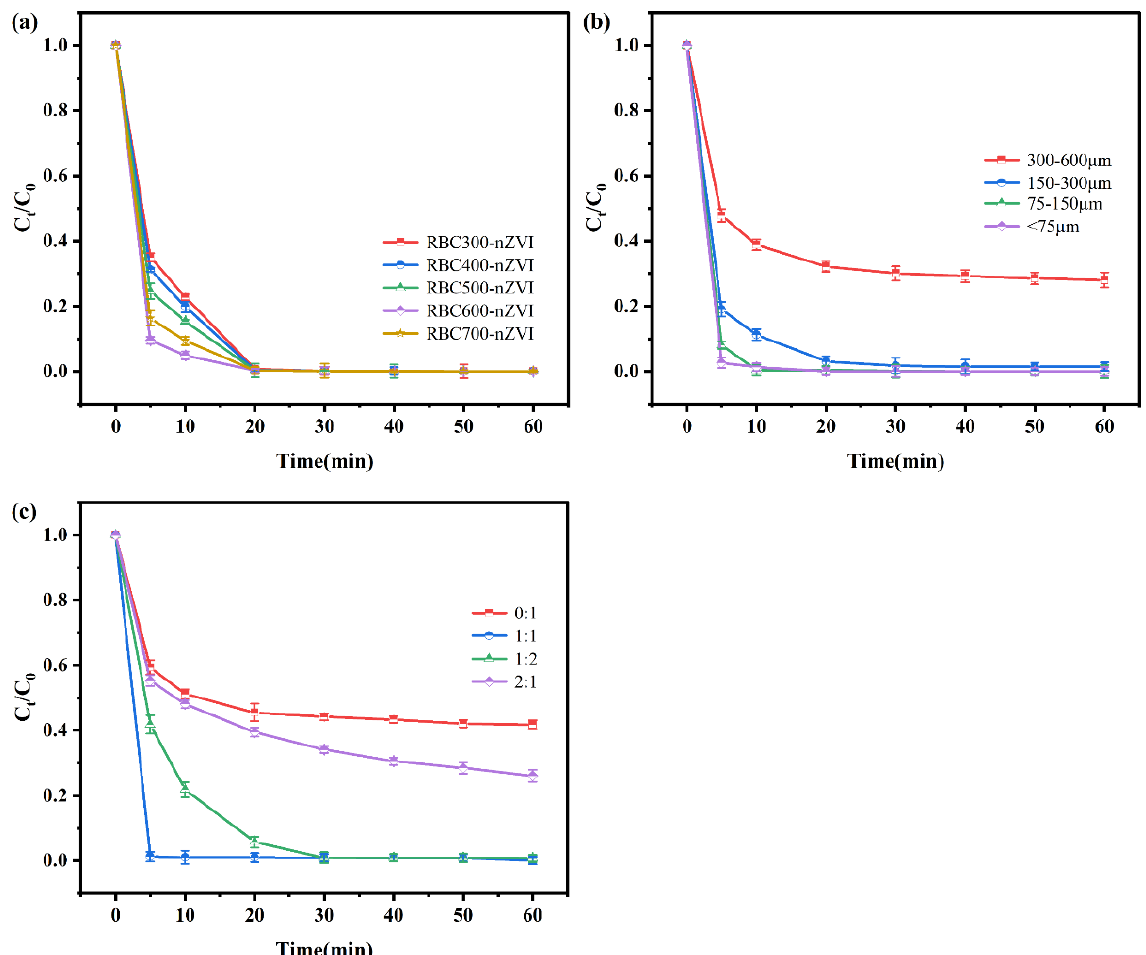
Figure 5. The removal of Cr(IV) by nZVI loaded with RBC600 prepared at different pyrolysis temperatures ( a ); NZVI loaded with different particle size RBC600 ( b ); different mass ratios of RBC600 to nZVI ( c ). Vertical bars denote the standard deviations of the means ( n = 2). Experimental conditions: initial Cr(IV) concentration 20 mg/L, RBC-nZVI dosage 1 g/L, T = 25 °C, pH = 5.